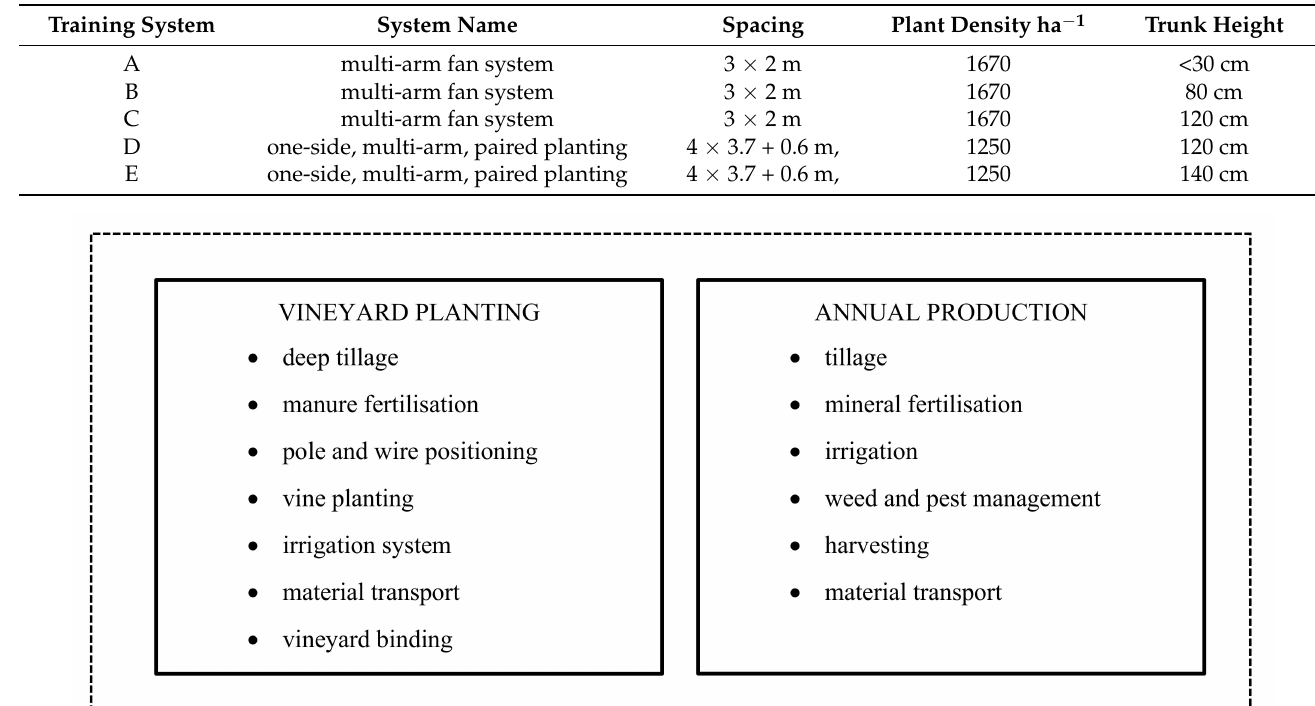
Table 3. Training system description.